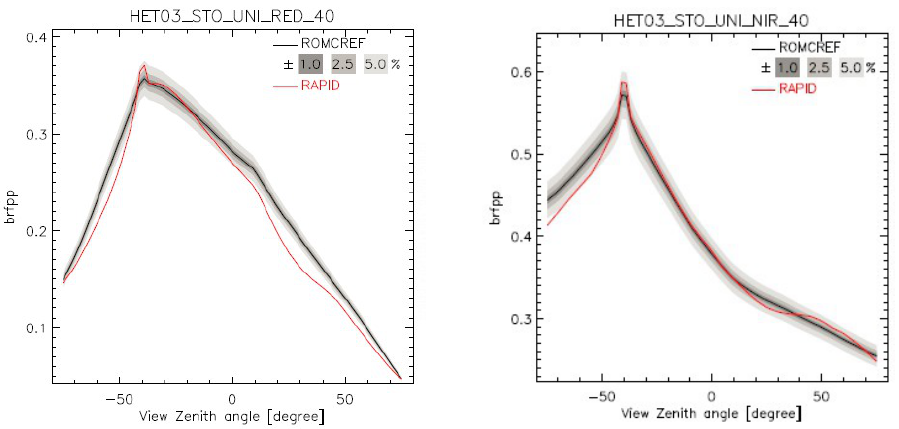
Figure 11. Comparisons of HET03 BRF results in the principal plane (brfpp) with the reference data from the RAMI online checker (ROMCREF).